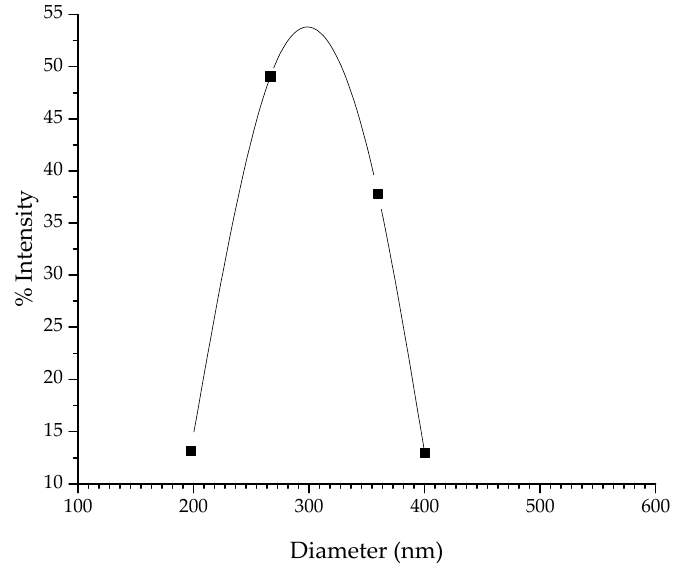
Figure 7. Size distribution of NAX as a function of the relative amount of light emitted by each population (% Intensity).